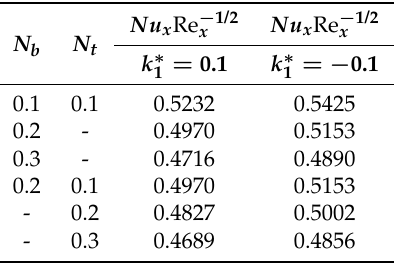
Table 3. Local Nusselt number for various estimations of viscoelastic, Brownian motion and thermophoresis parameters when Sc = Pr = 1.0 and M = 0.2.